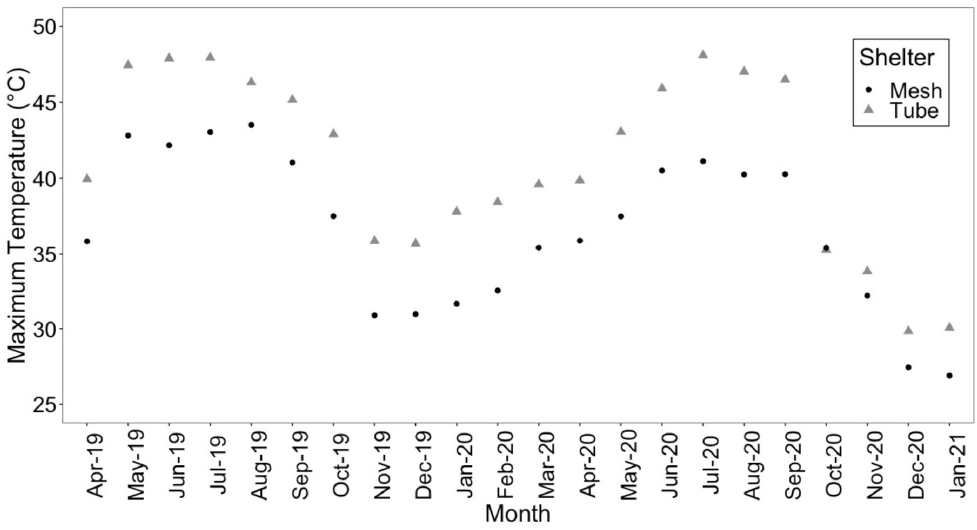
Figure 2. Maximum air temperatures (°C) averaged by shelter treatment (mesh and tube shelters included) from April 2019 to January 2021. Air temperature was recorded every 15 min.